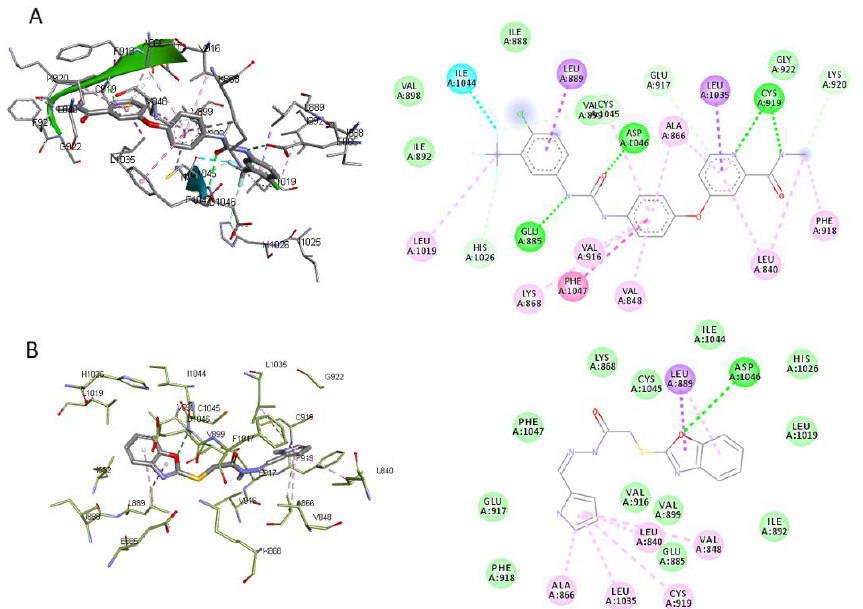
Figure 3. Schematic 2D and 3D depictions of the molecular simulation of sorafenib ( A ) and compound 6b ( B ) within the ATP-binding site of VEGFR2 (PDB ID: 4ASD). Green dotted lines represent hydrogen bonding.